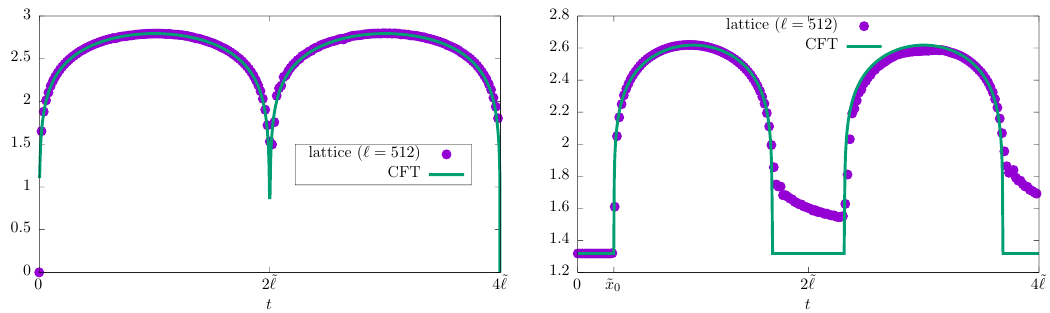
Figure 7: Entanglement entropy after the cut-and-glue quench, and comparison with the CFT formula (71). As in Fig. 6 we chose f ( u ) = 1 / ( 1 + 3 u 2 ) , which implies ˜ (cid:96) = 2 (cid:96) , to make the = 0, with excellent agreement. Right: Cut chain inhomogeneous. Left: Cut in the center, x 0 = (cid:96)/ 2, with very good agreement, but slight deviations. Note that the entropy at x 0